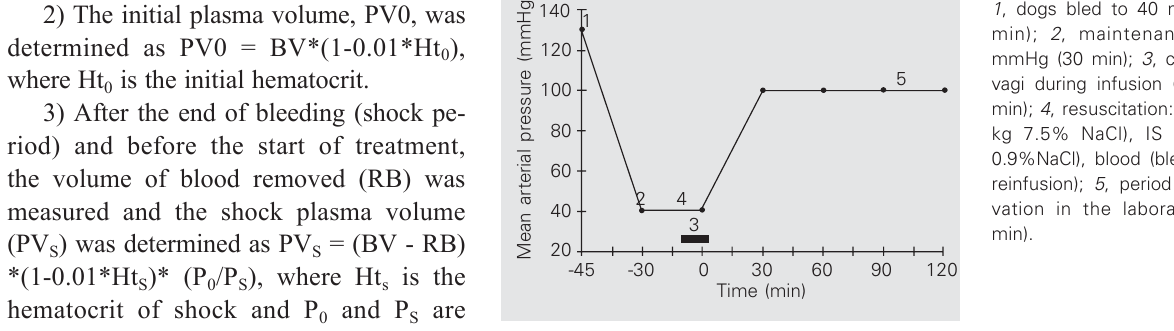
Figure 1. Experimental